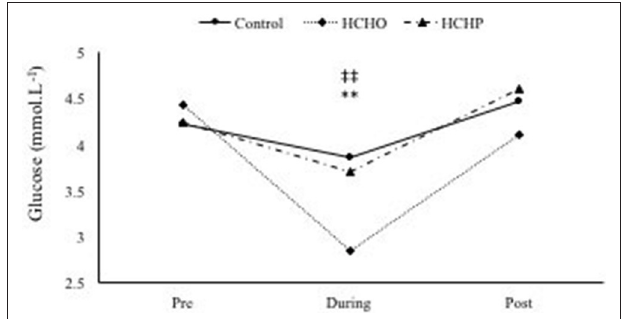
FIGURE 6 | Glucose concentration during HIIE protocol in control, HCHO and LCHP conditions. ** p < 0.01 between HCHO and control condition, and ‡‡ p < 0.01 between HCHO and LCHO condition. Values are means ± SEM, n =